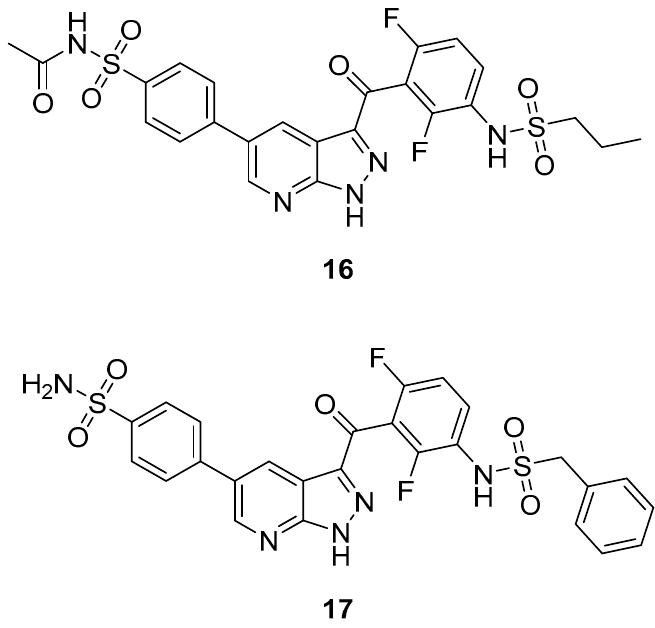
Figure 11. Pyrazolopyridines. Figure 11.